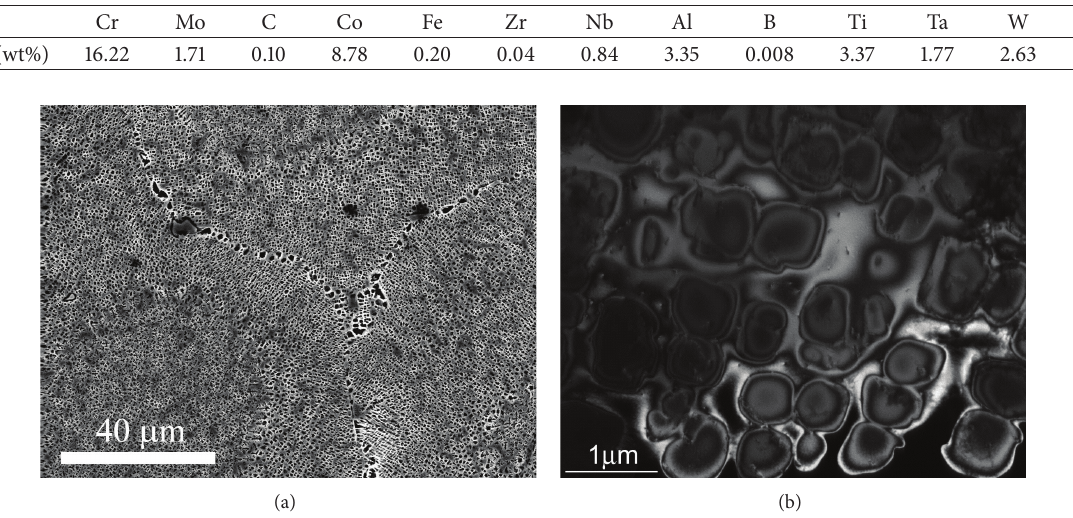
Figure 1: Micrographs of the investigated IN738LC superalloy in as-delivered conditions: (a) SEM (secondary carbides at grain boundaries are visible as well) and (b)